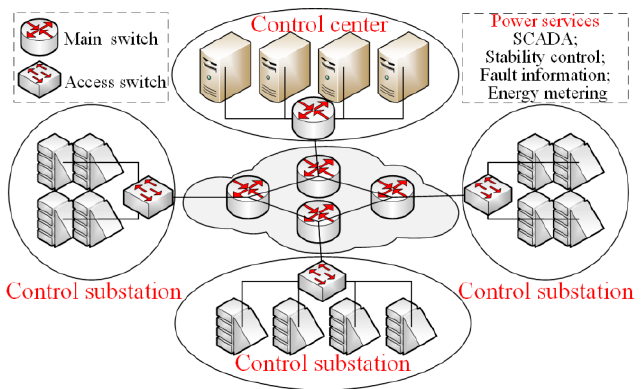
Figure 4. Structure of wide area information and communication network.